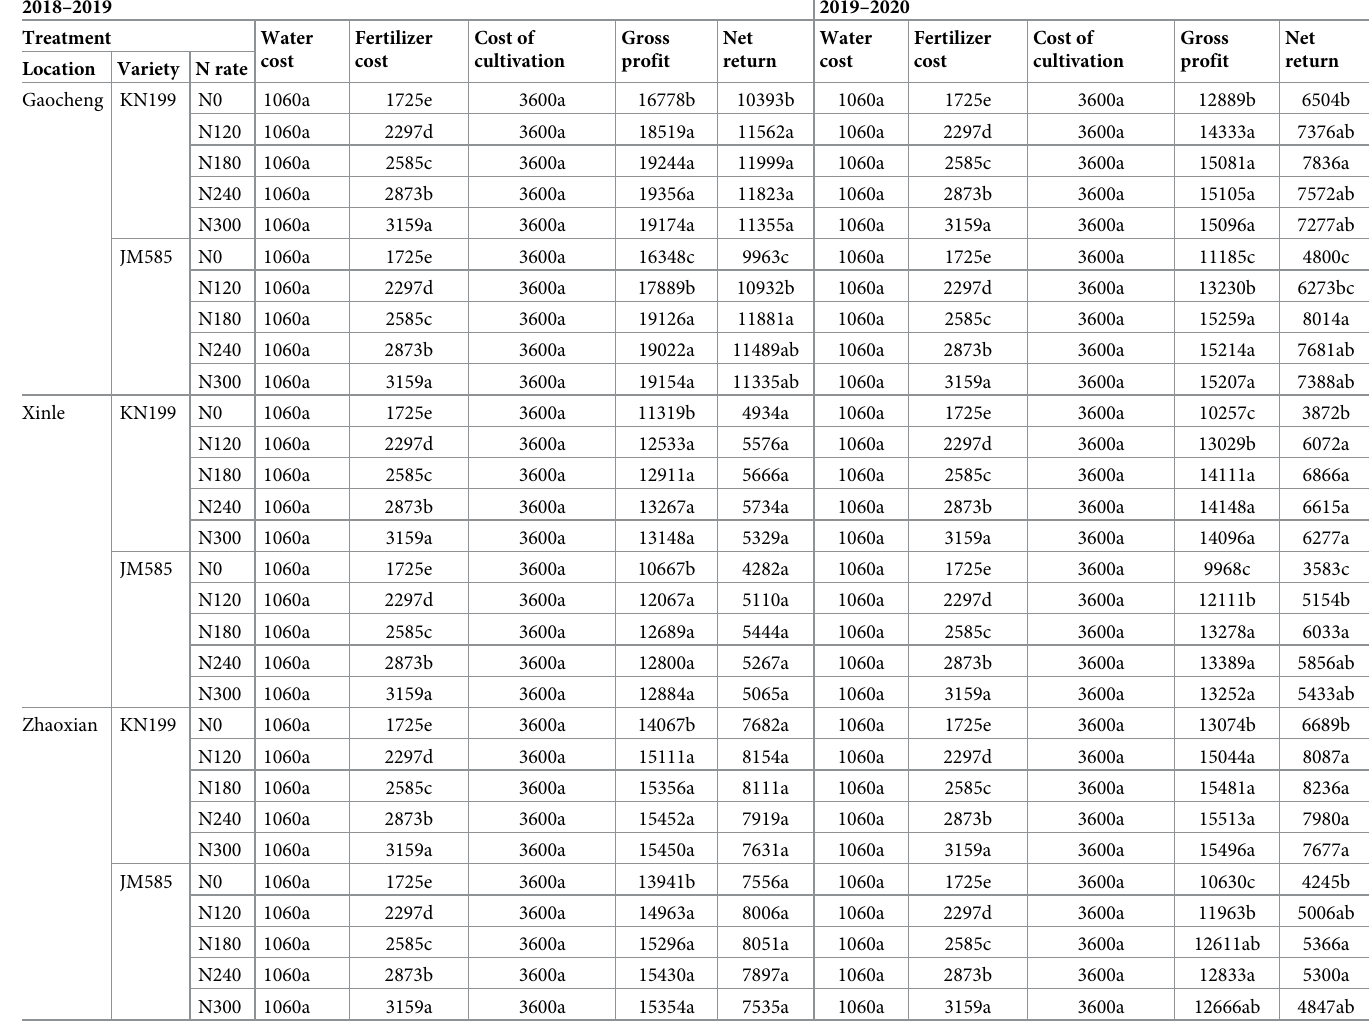
Table 4. Economic return (CNY ha -1 ) of different winter wheat varieties under different nitrogen fertilization rates in three experimental sites during 2018–2020